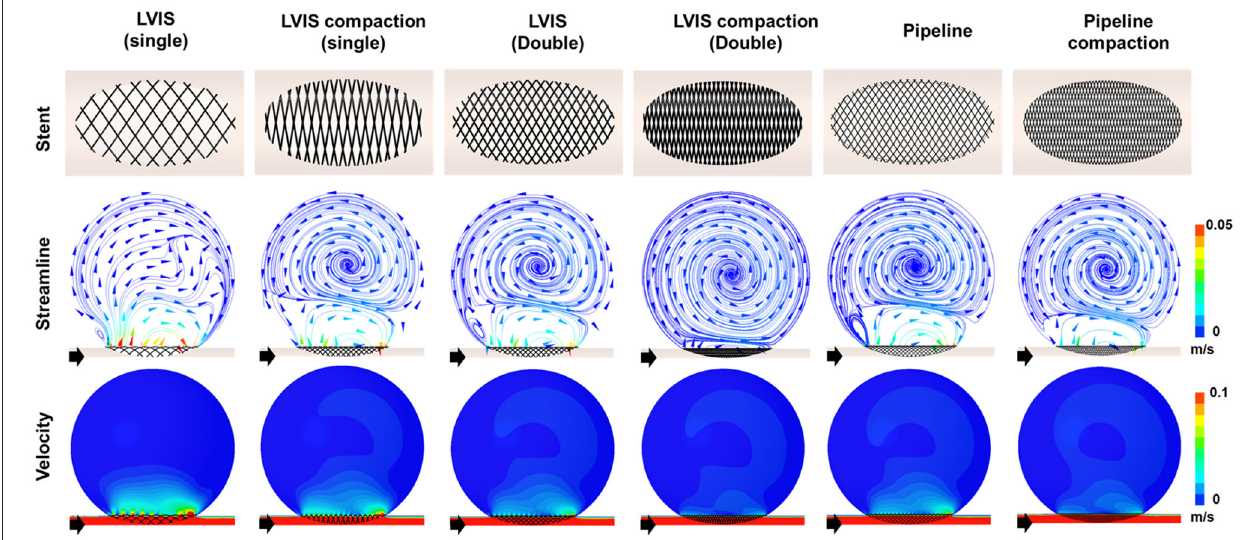
FIGURE 5 | Visualization of the hemodynamic modification induced by compacting the stents. The stent configuration deployed in an idealized aneurysm model and the streamlines and velocity contours calculated using CFD analysis are displayed. The black arrows indicate the flow direction. Stent compaction improved the flow diversion effect of both the LVIS and Pipeline devices. The compacted LVIS stent induced a similar decrease in the velocity magnitude and change in the flow pattern as the two uncompacted LVIS devices or single uncompacted Pipeline device. CFD, computational fluid dynamics.